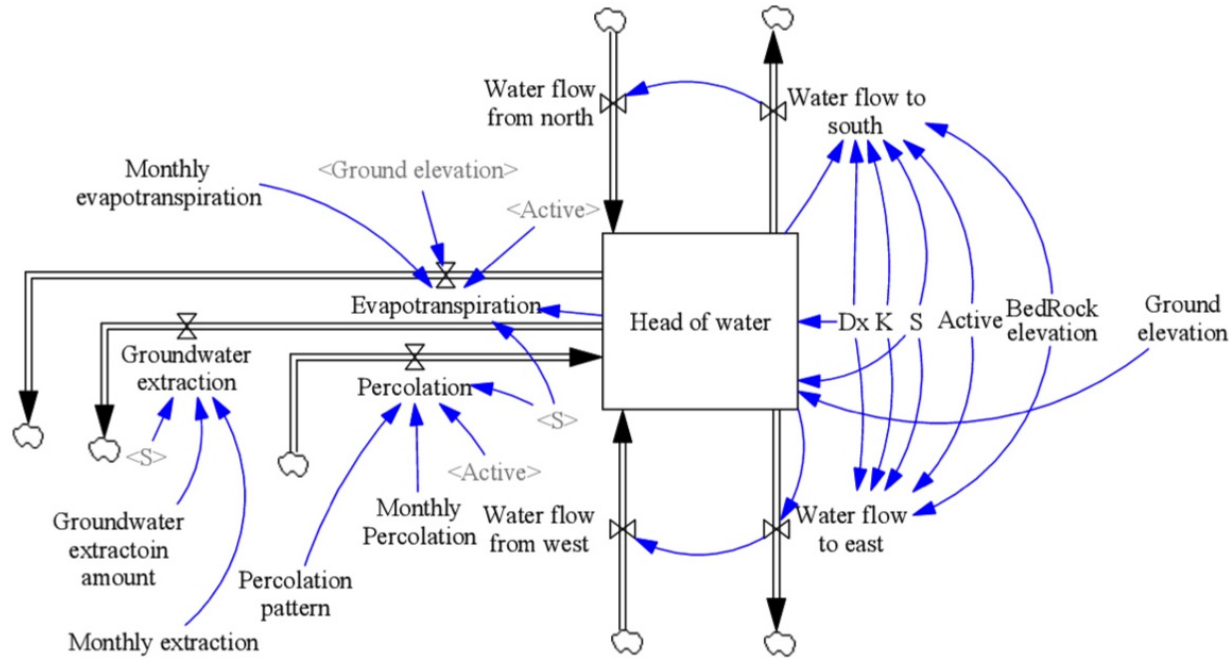
Figure 2. System dynamics model of the groundwater-modeling segment. Representing the active or inactive cells in the modeling domain, “active” is an auxiliary variable, which can also serve to define aquifer boundary conditions; S represents aquifer specific yield; Dx represents the length of one side of the cell; and K is the hydraulic conductivity of each cell in the